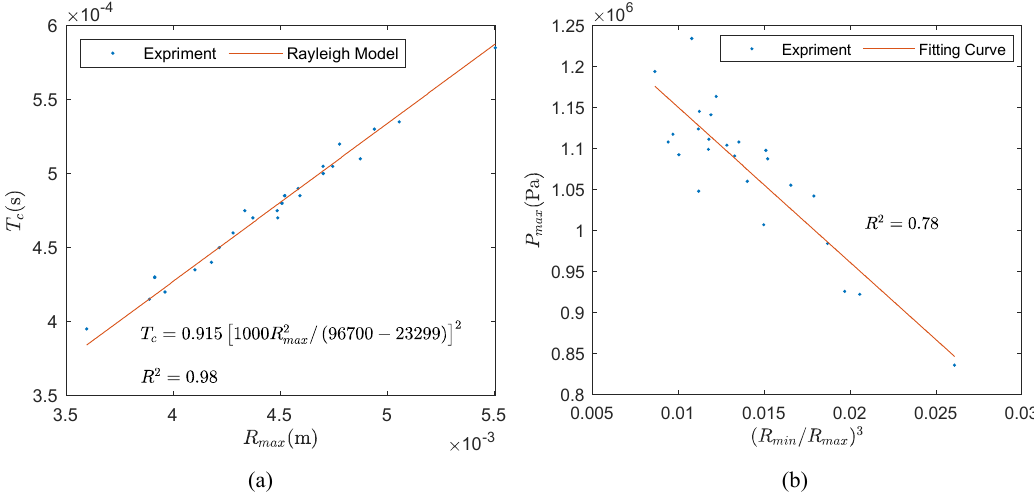
Figure 9. The statistical correlation of cavitation bubbles. ( a ) The correlation between the maximum radius and the period; ( b ) the correlation between the maximum pressure and the volume ratio.